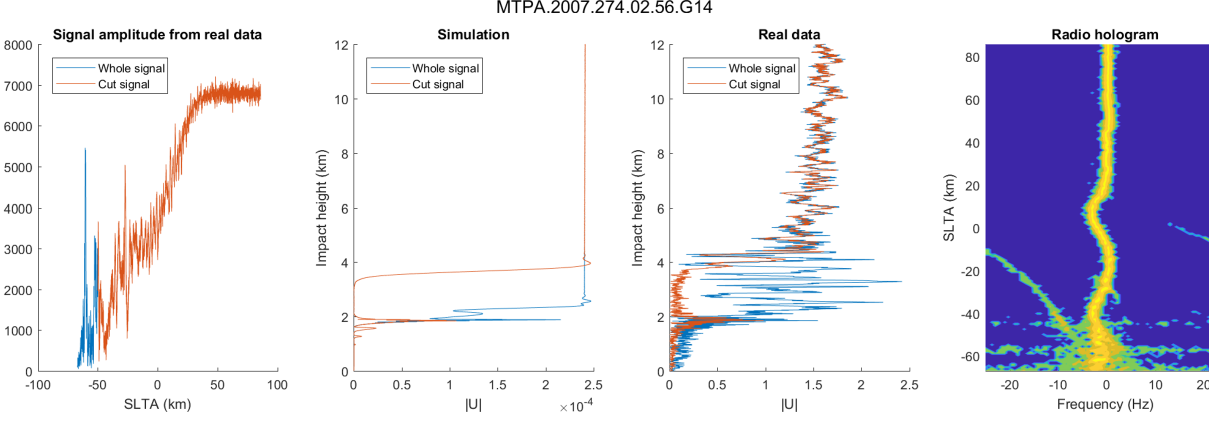
Figure 6. An event classified as category 1. SLTA min is at approximately − 65km, and the signal is truncated at SLTA = − 50km. The reflection spike is located at an impact height of 1849m, and a min is